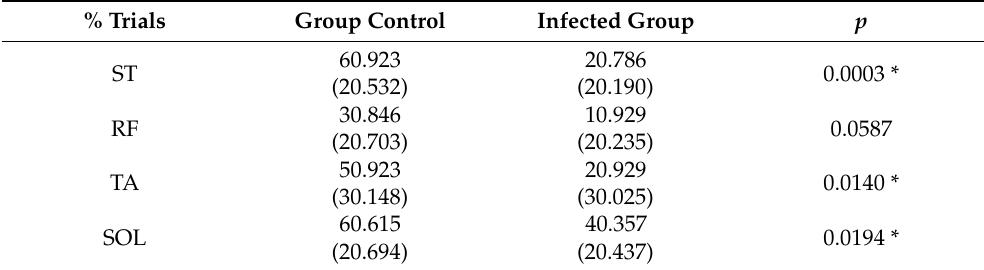
Table 3. Statistical analysis of the percentage of EMG trials between the control and infected groups using the Mann–Whitney test. The ST, TA, and SOL muscles present significant differences between the groups, with a higher percentage density (%) of trials in the control